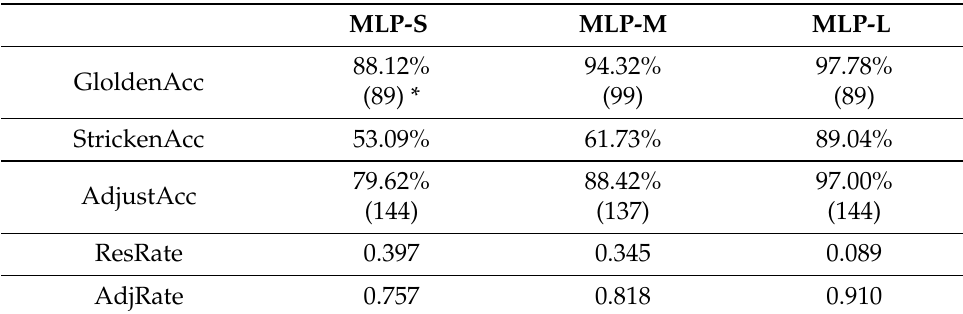
Figure 6. The ACIMS experiment on MNIST with different scaled models. In the first 100 epochs, ACIMS trains the original MLP model; the best accuracy is dotted and labeled GoldenAcc. The vertical dashed line indicates that the fault pattern is injected at the 100th epochs and the point on the line marks the StrickenAcc. In the last 50 epochs, ACIMS retrains the fault injected model; the best accuracy is dotted and labeled AdjustedAcc. Table 2. The ResRate and AdjRate of MNIST in different scales